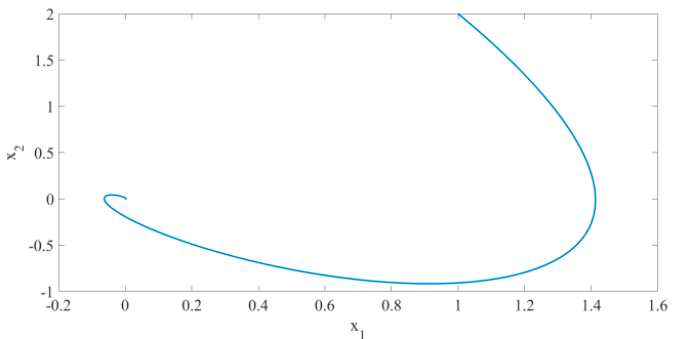
Figure 6. Time response of system with known parameters (without disturbance, λ 1 = − 2, λ 2 = − 3).